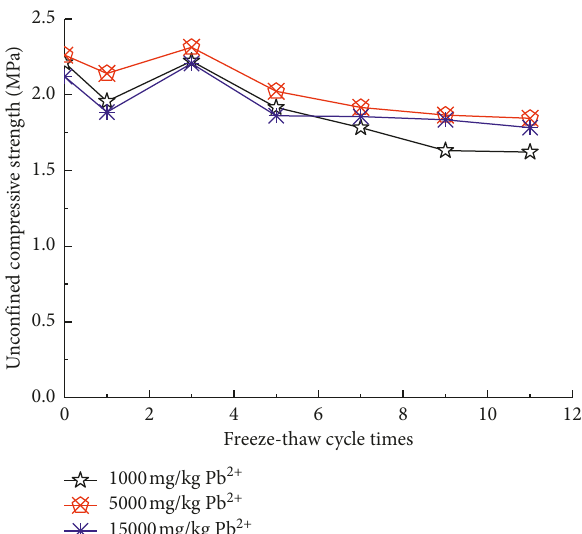
Figure 2: Relationship between unconfined compressive strength and times of freeze-thaw cycle of 15% cement solidified/stabilized contaminated soils with different heavy metal contents.